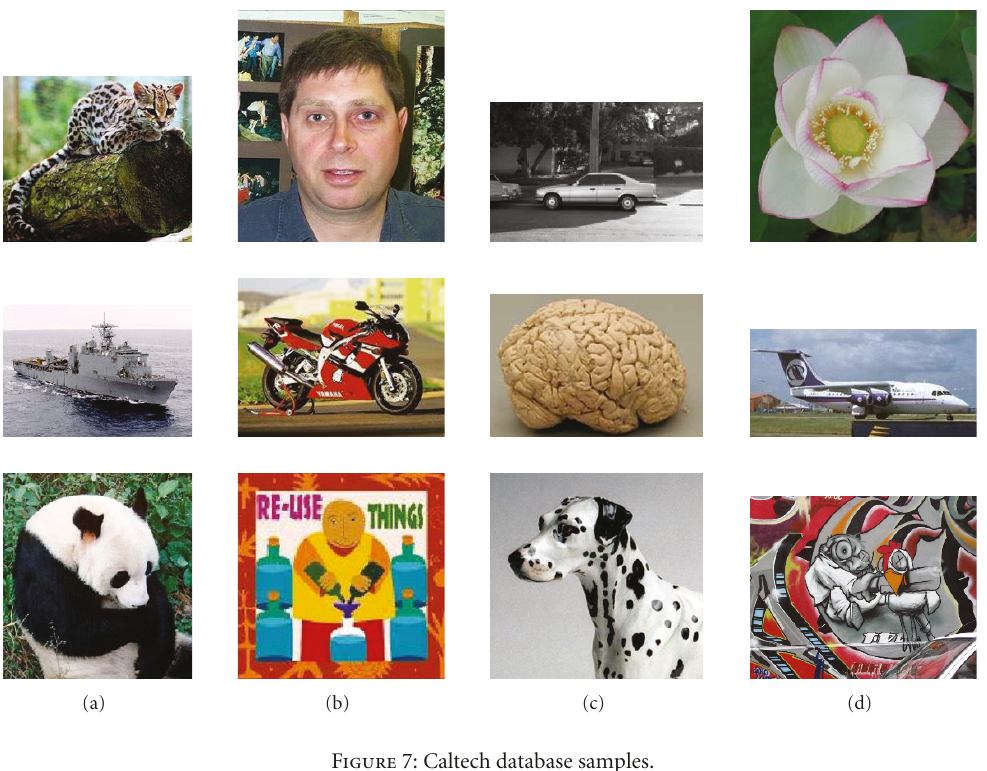
Figure 7: Caltech database samples.